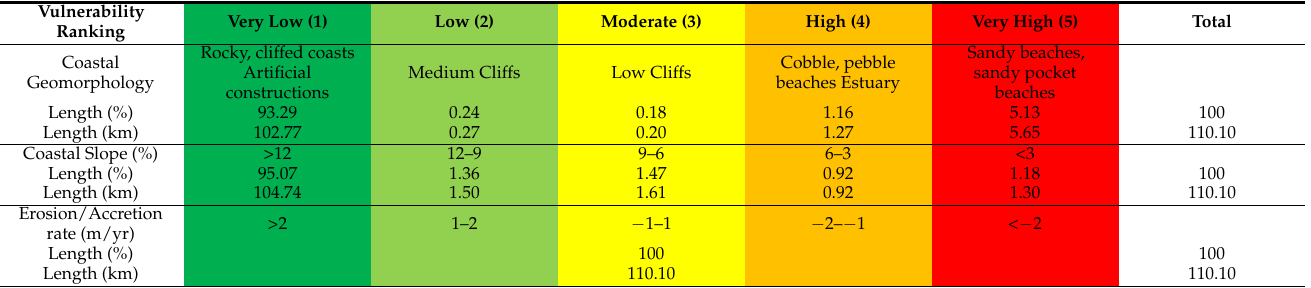
Table 2. Ranking of the geological variables: Coastal Geomorphology; Coastal Slope; Shoreline displacement rate (Erosion/Accretion). The tables indicate the length, in km and percentage, of coastline in each category of